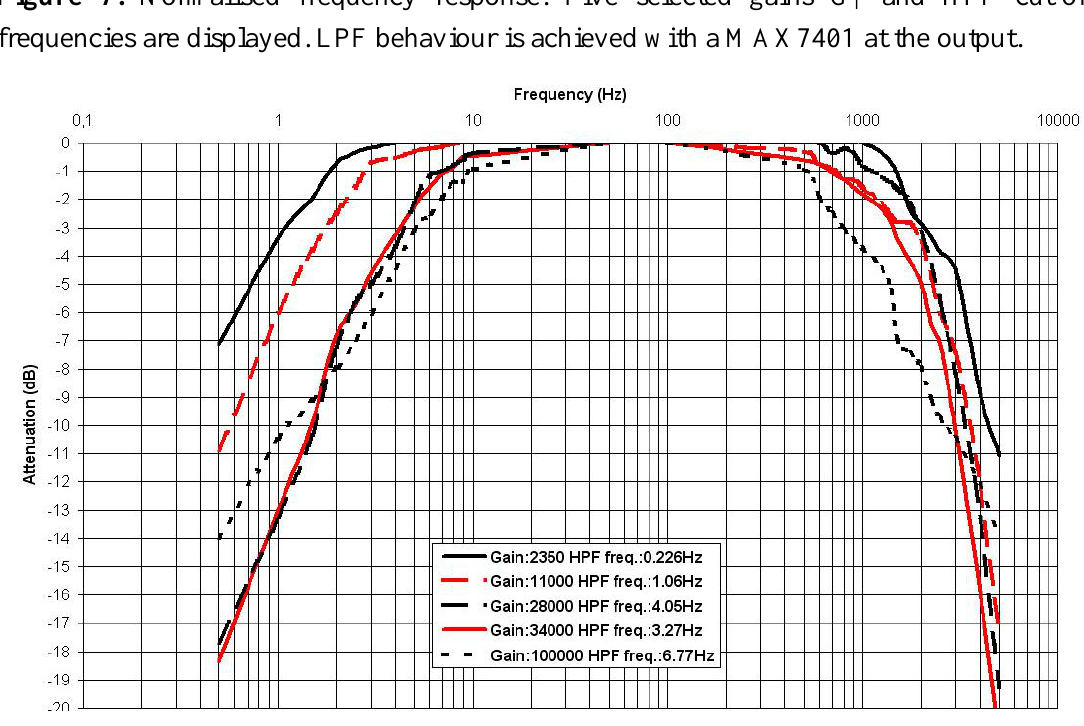
and HPF cut-off T